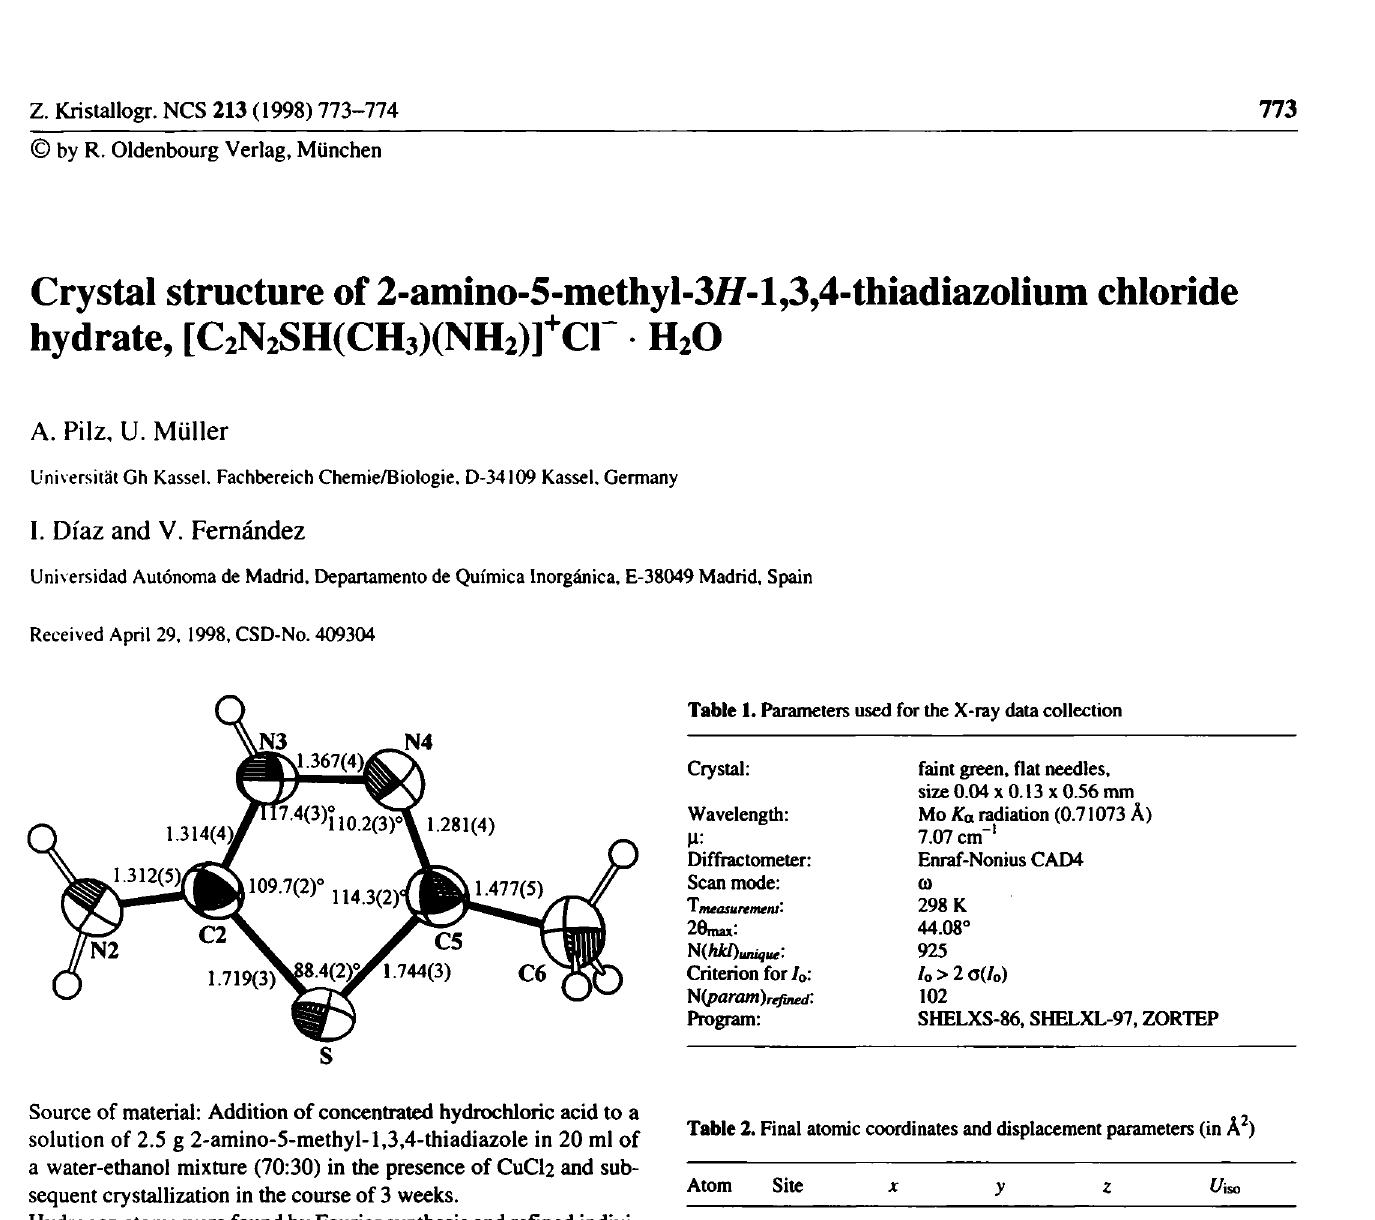
Table 2. Final atomic coordinates and displacement parameters (in